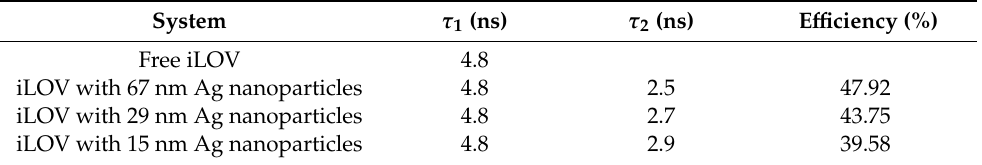
Table 2. Time-resolved fluorescence lifetimes and transfer e ffi ciencies of free iLOV and iLOV adsorbed onto silver nanoparticle surfaces.